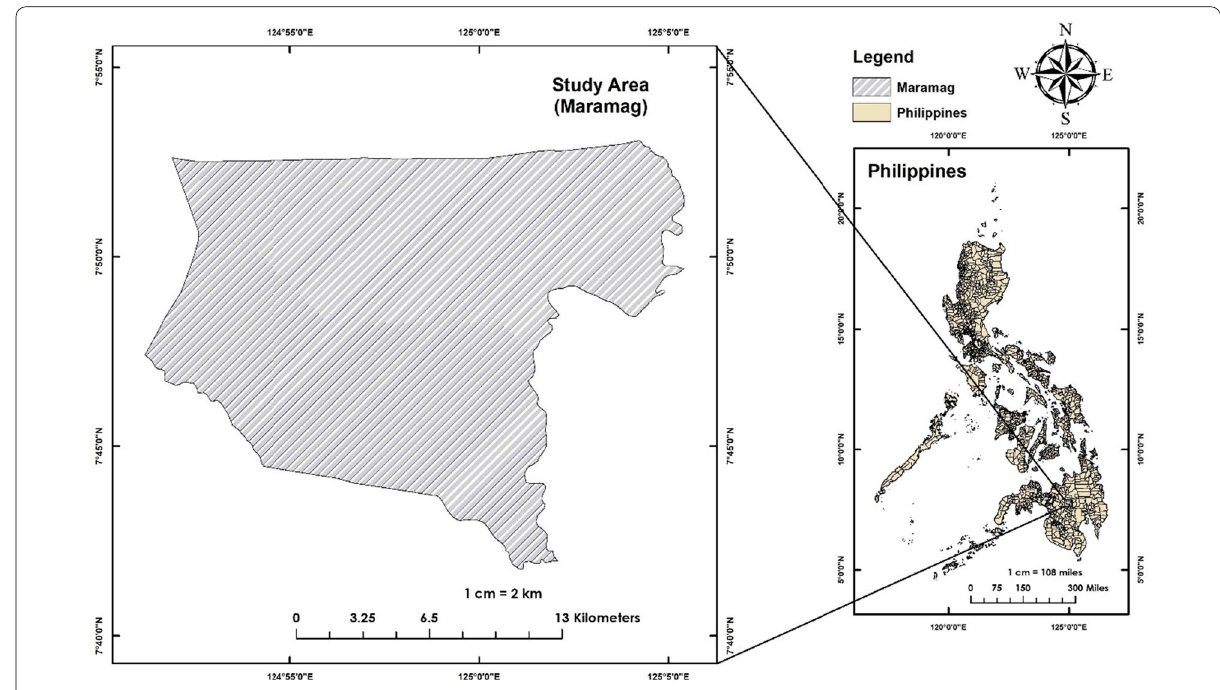
Fig. 1 Location of the field